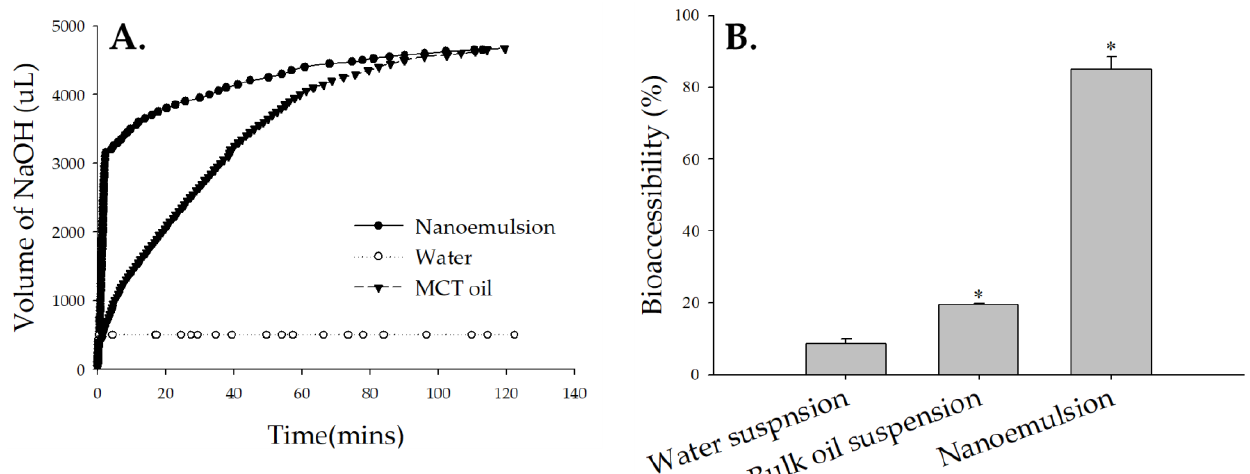
Figure 4. In vitro lipolysis profiles of pterostilbene nanoemulsion, bulk oil, and water suspension. ( A ) The digestion kinetics expressed as the amount of added NaOH as a function of time. ( B ) Percent pterostilbene bioaccessibility relative to the original dose in the nanoemulsion, bulk oil, and water. Data are presented as mean ± standard deviation ( n = 3). * = p < 0.01.